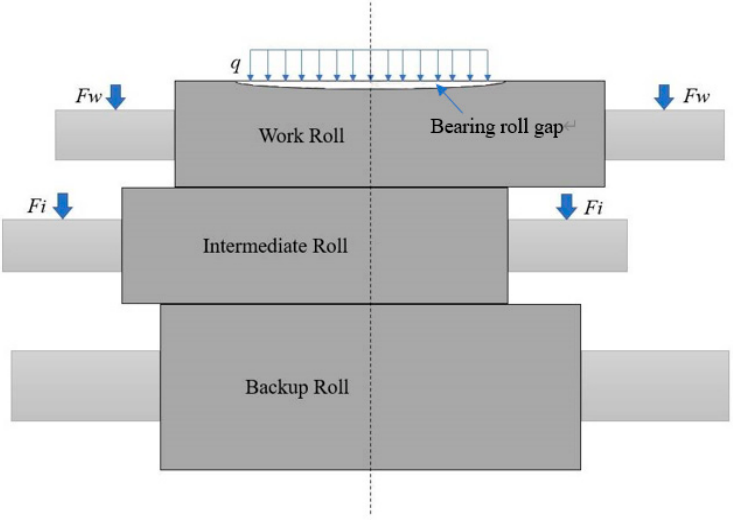
Figure 3. The bearing condition of the roller system.